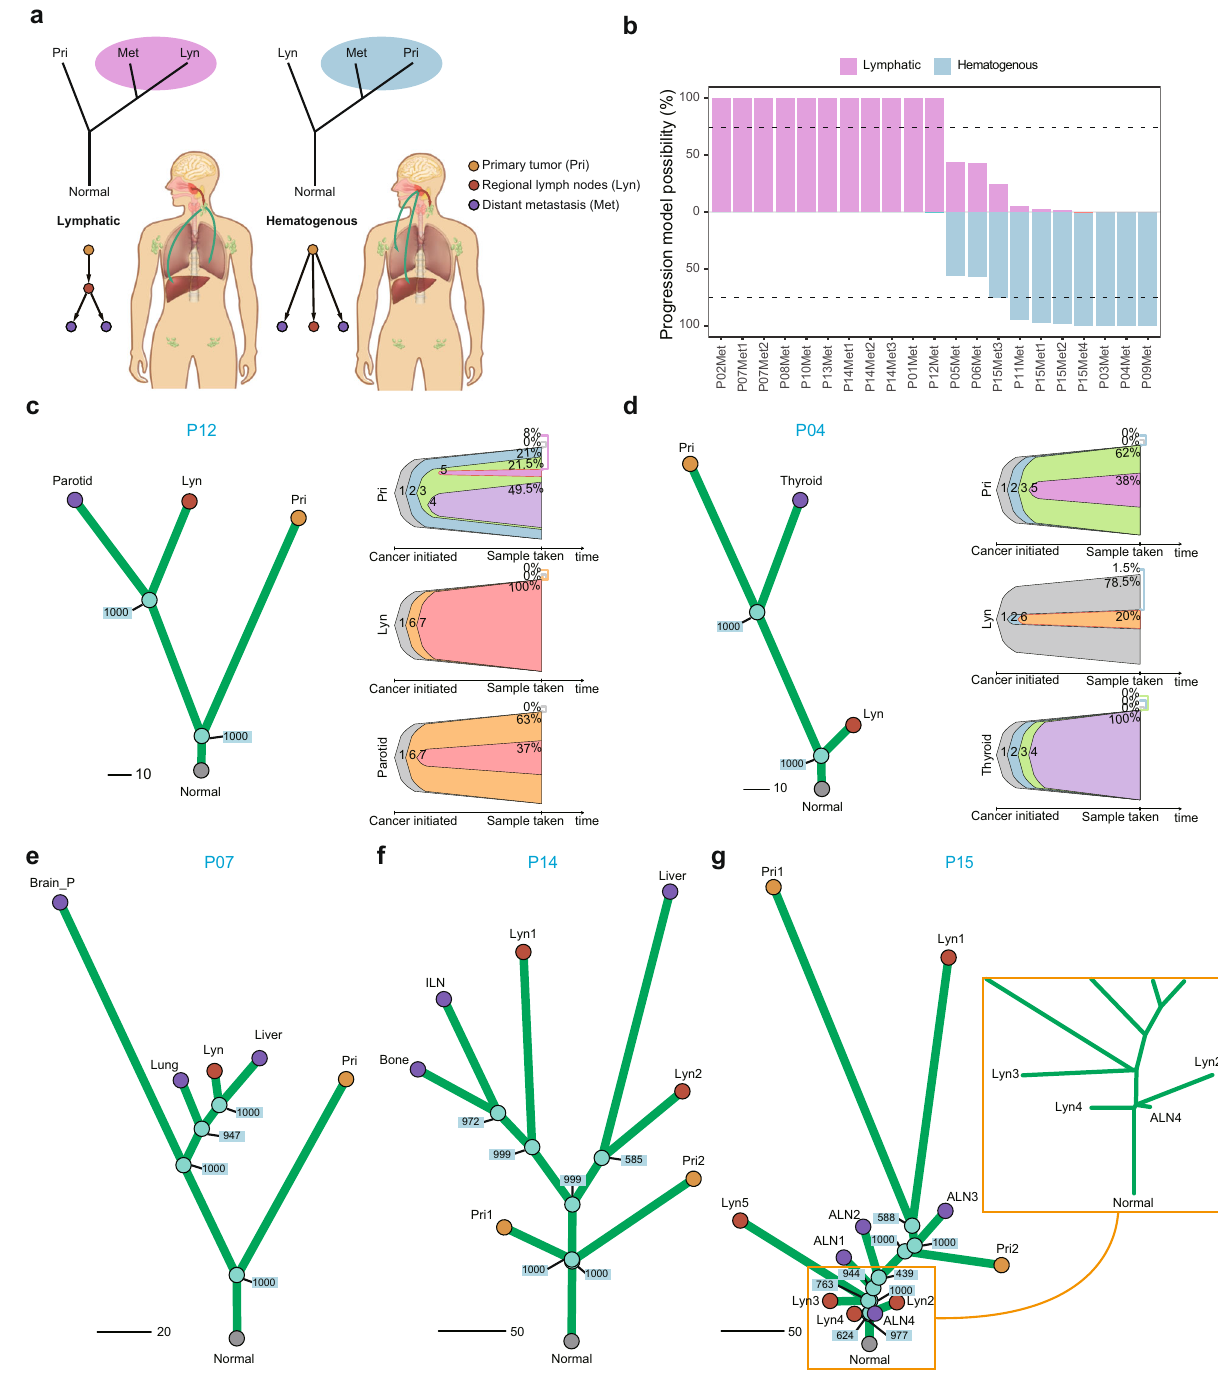
Fig.3| “ Lymphatic ” and “ hematogenous ” evolutionpatternofNPCmetastases indicated from genome sequencing data. a Schematic diagram illustrating the classi fi cation of distant metastases into lymphatic or hematogenous evolution patterns. b Bootstrapvaluesre fl ectingtheevolutionarypatterncon fi denceforeach distant metastasis in 15 patients with matched primary, regional lymph node metastasis and distant metastasis samples before treatment. Samples with both probabilities less than 75% (P05Met, P06Met), as indicated by the dashed lines, were too ambiguous for classi fi cation and were removed in downstream analysis. c , d Typical examples of lymphatic ( c ) and hematogenous ( d ) models. Left: Phy- logenetic tree with bootstrap values for each divergence node. Right: Subclone- based evolution analysis revealed the same pattern as the phylogenetic tree.